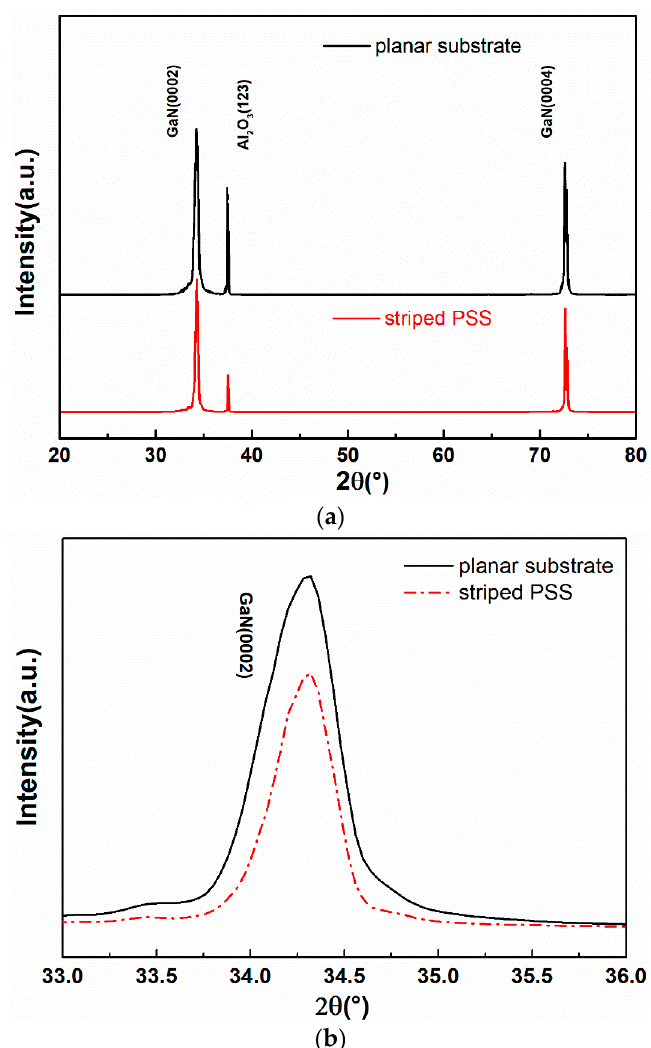
Figure 4. ( a ) X-ray diffraction patterns of GaN films grown on striped PSS and planar substrate, and ( b ) rocking curves for GaN films grown on striped PSS and planar substrate.